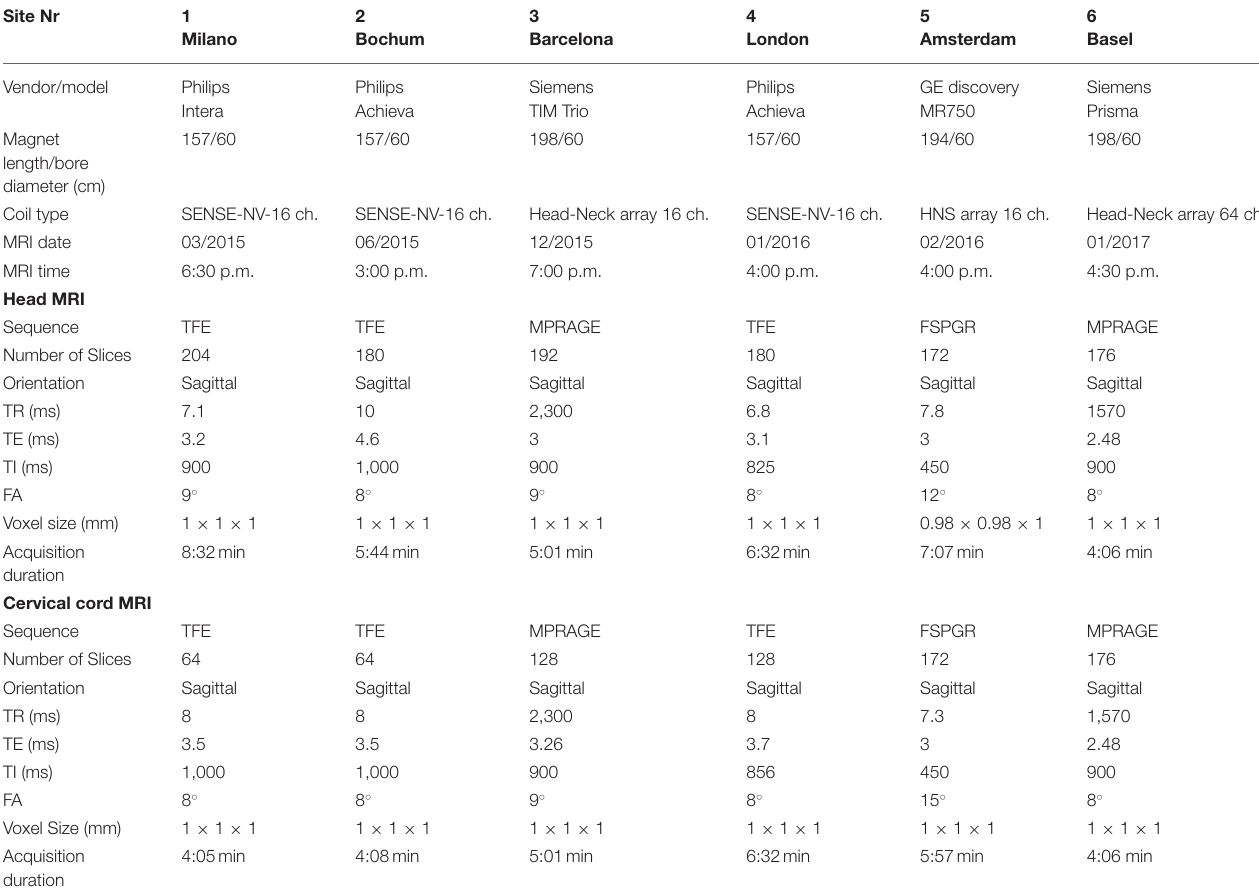
TABLE 1 | Sequence parameters used with the 3-Tesla scanners at the participating